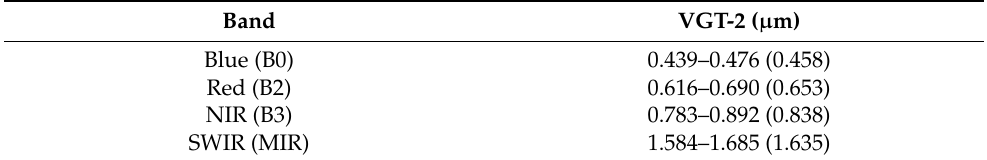
Table 2. VGT-2 spectral bands, full width at half maximum and centre wavelength in